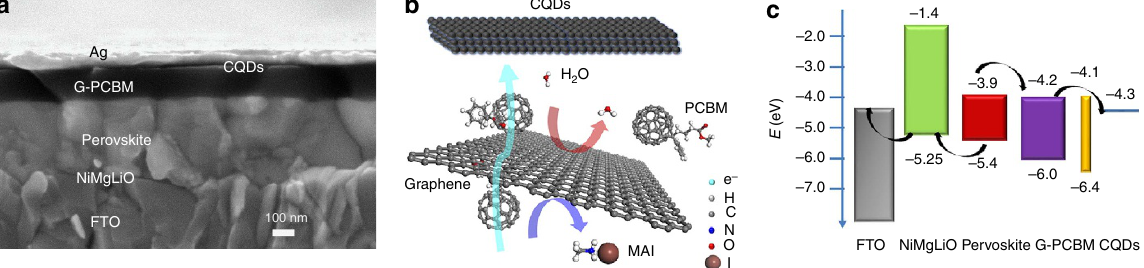
Figure 1 | Planar heterojunction PSCs using a nanocarbon layer to suppress layer-to-layer ions/molecules diffusion and facilitate electron charge carrier diffusion. ( a ) SEM cross-section image of a NiMgLiO/Perovskite/N-doped graphene fullerene derivative phenyl-C61-butyric acid methyl ester (G- PCBM)/CQDs/Ag device, in which G-PCBM is graphene doped PCBM. ( b ) Schematic drawing of the diffusion processes within the nanocarbon-based EEL. ( c ) Energy band structure of the planar heterojunction